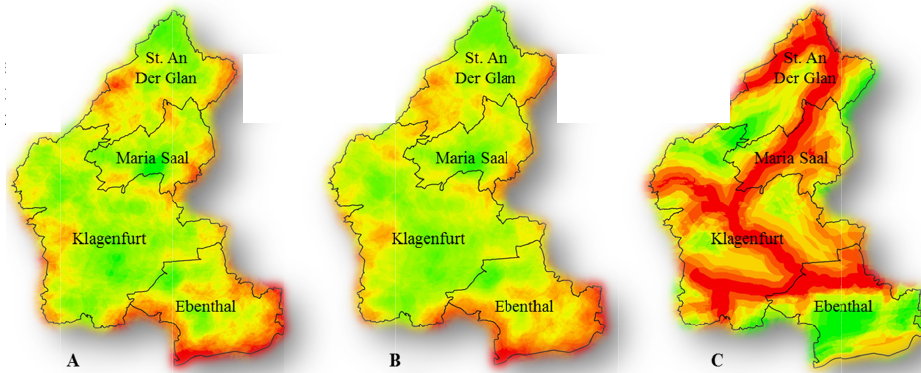
Fig. 2. Three components of 2009 SRI analysis.